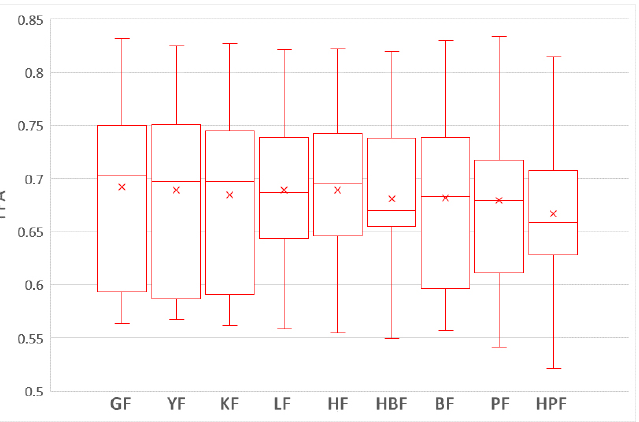
Figure 3. The boxplots of the nine training data selection methods with the Scott–Knott test results in terms of FPA.